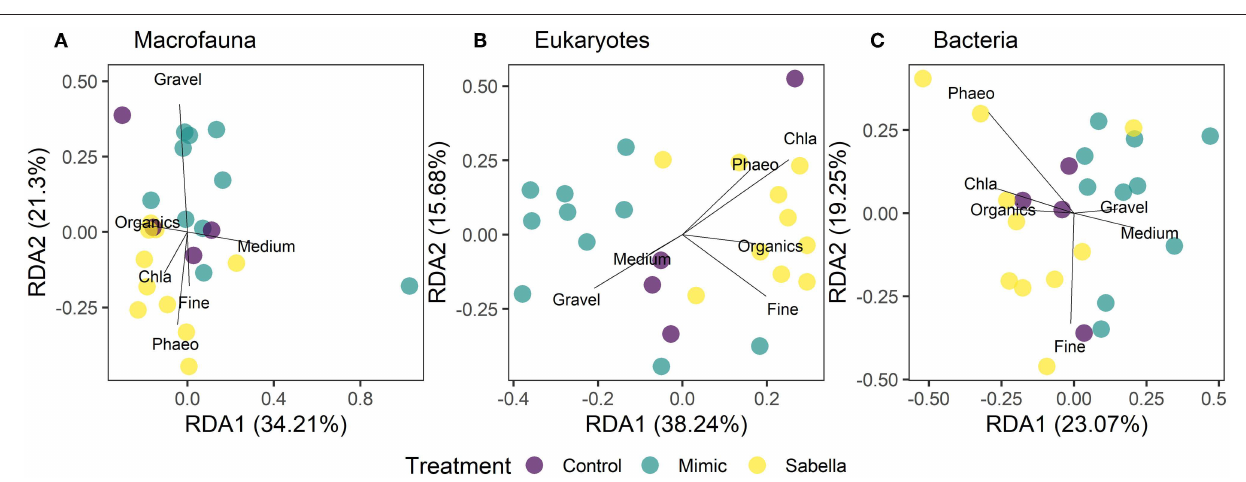
FIGURE 7 | Distance-based redundancy analysis (dbRDA) ordination of first and second fitted axes relating the environmental variables to the faunal data (A) macrofaunal, (B) eukaryotes, and (C) bacterial communities in “Control” (purple circles), “Mimic” (green circles) and “ Sabella ” (yellow circles) experimental plots. Biplot projections are given for the sediment environmental variables. Vectors are plotted showing the correlations of environmental variables with dbRDA axis 1 and dbRDA axis 2, with the length and direction of the arrow representing the strength and direction of the relationship. and their mimics. This effect was consistent across benthic macrofaunal, eukaryote and bacterial assemblages, and